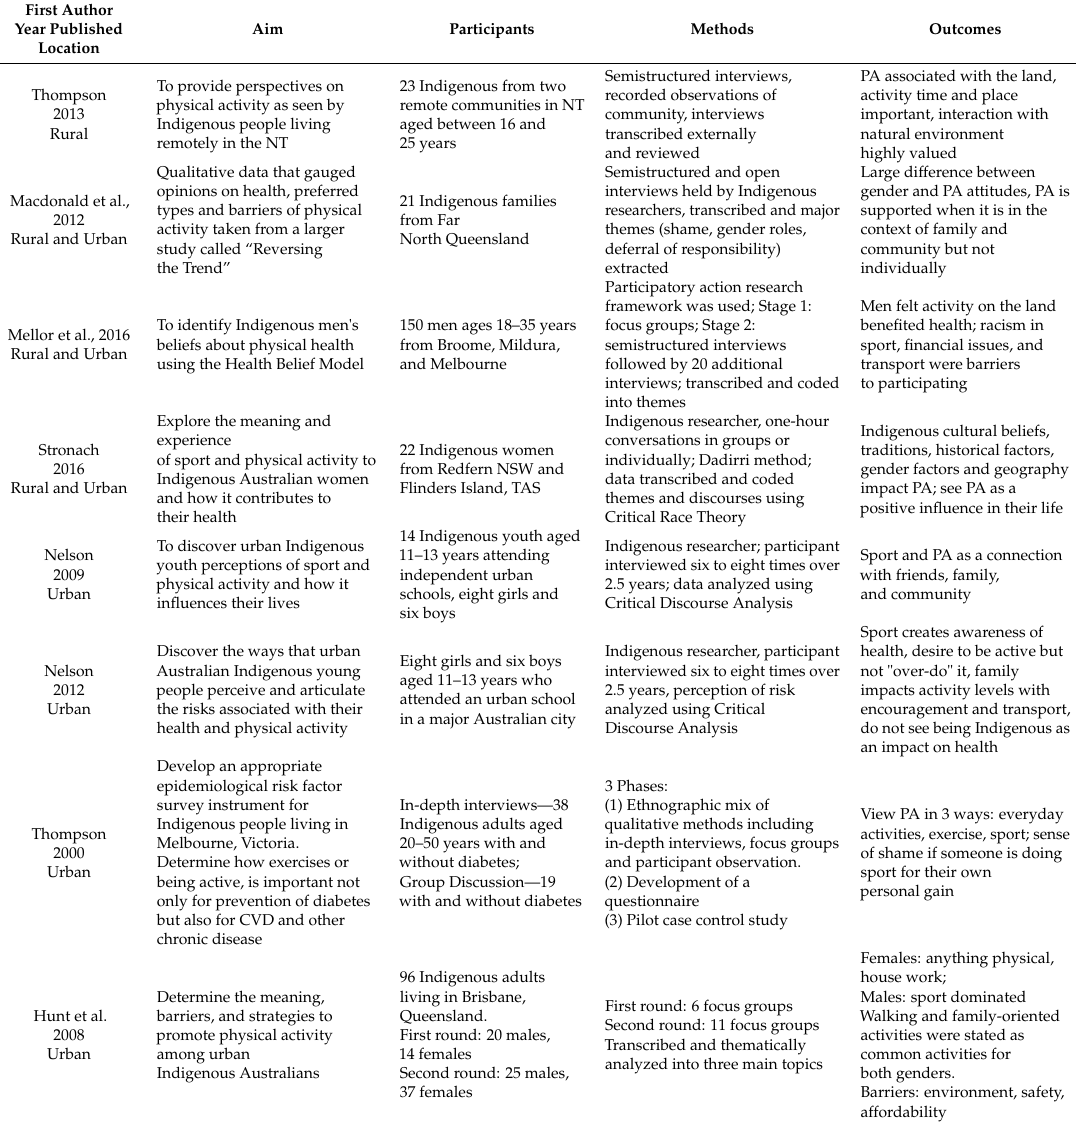
Table 1. Description of included studies.